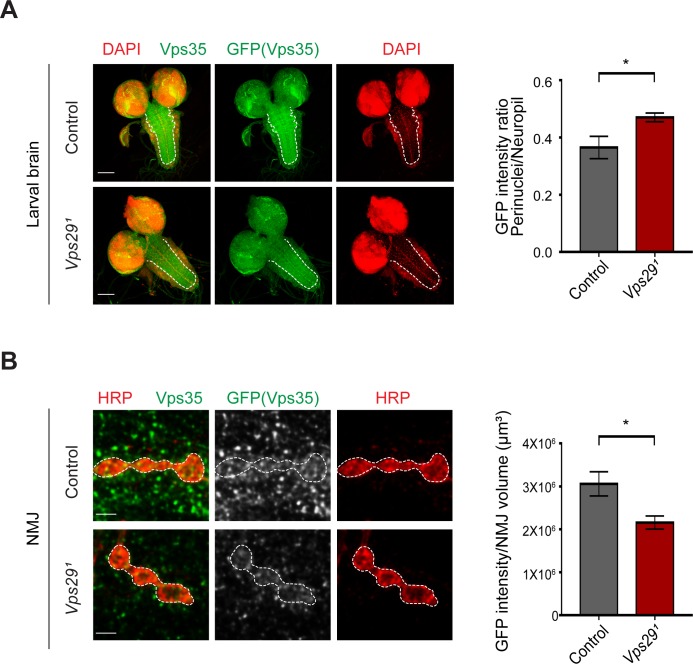
Loss of Vps29 causes mislocalization of Vps35 in larvae.(A) In Vps291 larval brain, Vps35GFP (green) protein is reduced in the neuropil (dashed line). Nuclei are labeled with DAPI (red). The GFP intensity ratio (perinuclear to neuropil) was quantified (n = 7–8) in Vps291, Vps35GFP homozygotes or Vps35GFP controls. Scale bars, 100 µm. (B) Vps35GFP is reduced at the larval NMJ in Vps291 mutant animals. NMJ preparations from Vps291, Vps35GFP homozygotes or Vps35GFP controls were co-stained with anti-HRP and anti-GFP, and GFP intensity within Type IIb boutons at abdominal segments A2 and A3 were calculated relative to HRP volume (n = 7 animals per group). Scale bars, 2 µm. Statistical analysis based on Student’s t test. All error bars denote SEM. *, p<0.05.